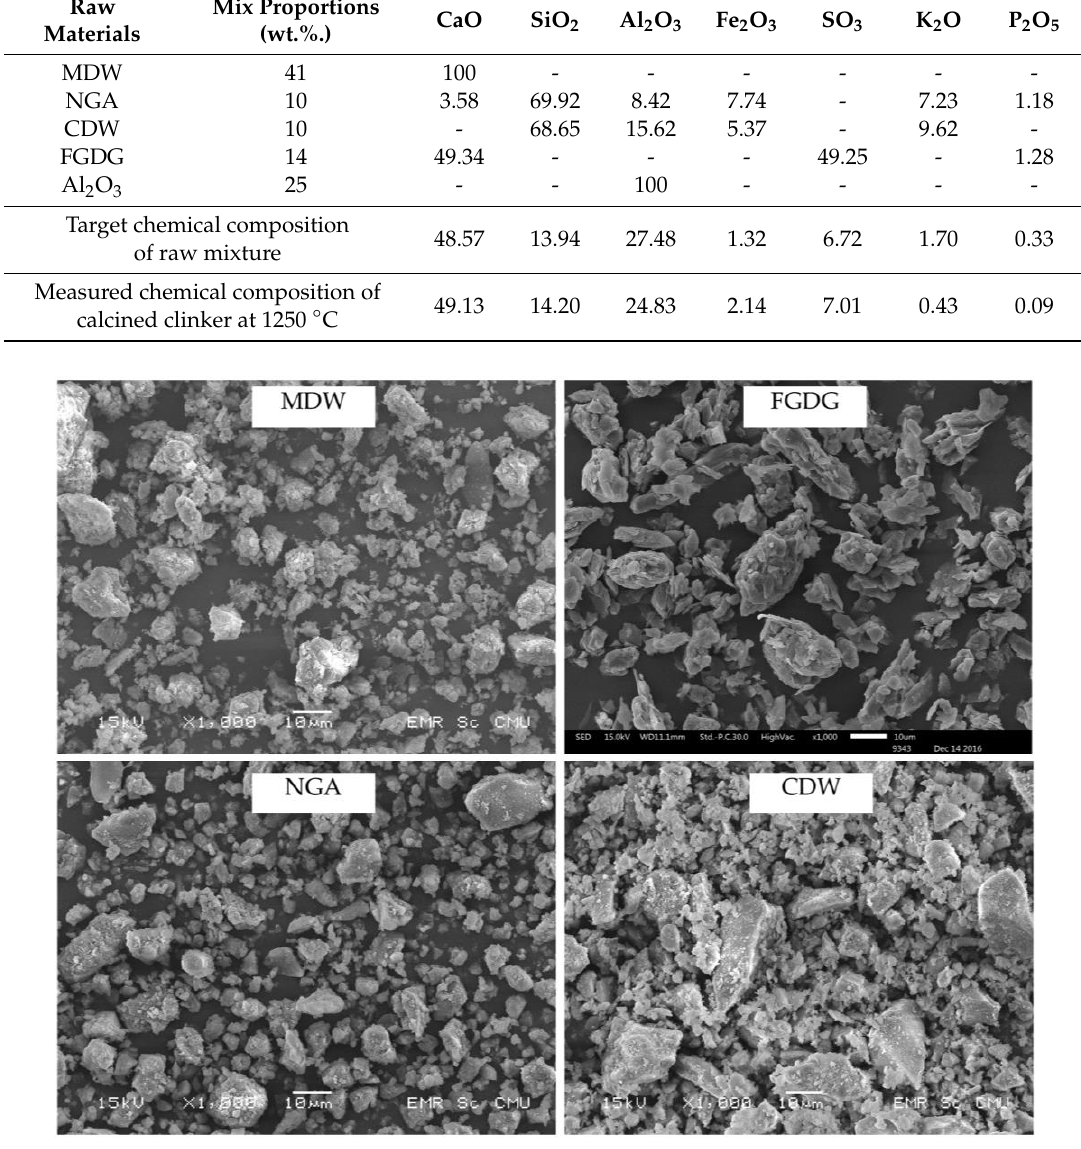
Figure 2. SEM images of the four raw materials used. Table 2. Chemical composition of the four industrial waste materials used, laboratory reagent grade Al 2 O 3 powder, target chemical composition of the raw mixture, and measured chemical composition of the clinker fired at 1250 °C.